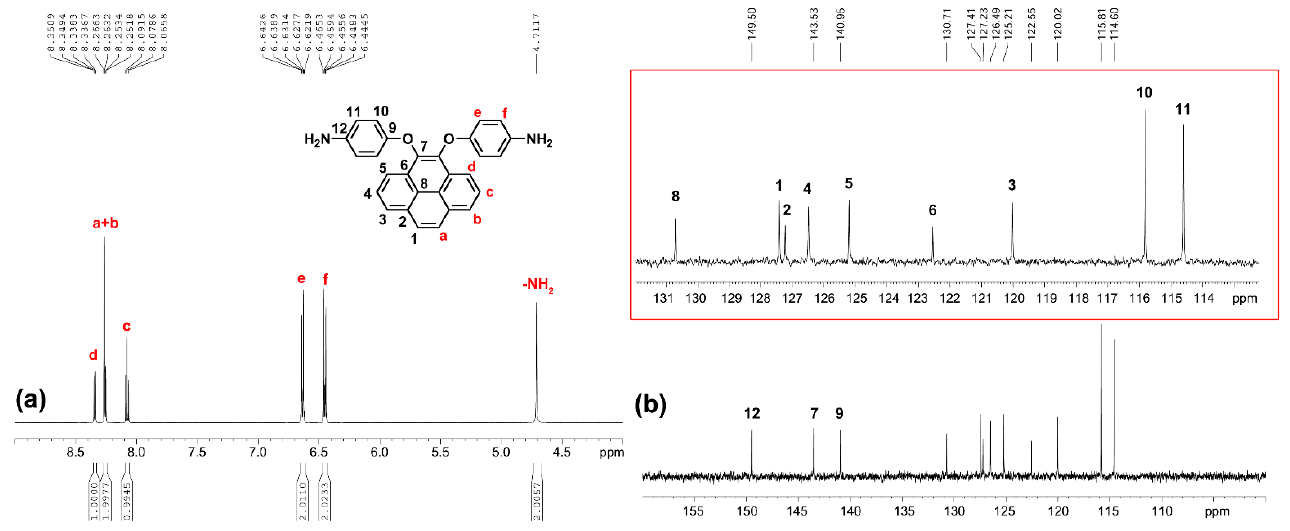
Figure 2. ( a ) Proton and ( b ) carbon NMR spectra (enlarge region between 110 to 132 ppm as shown in red frame) of monomer 3 in DMSO-d 6 .